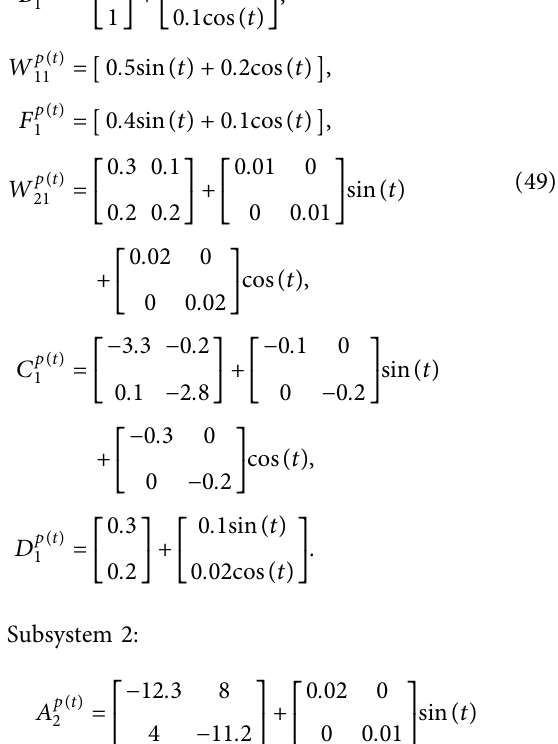
Figure 1. The state trajectory x ( t ) and y ( t ) of the closed- loop PV-HMJSs (8) are shown in Figures 2 and 3.